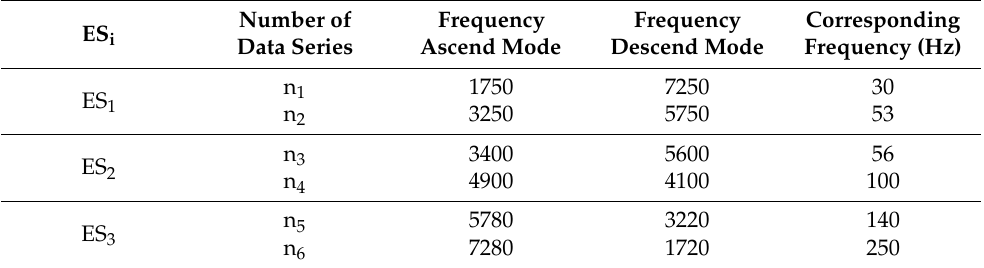
Table 3. Numbers of data series corresponding to the start and end frequencies of ES i